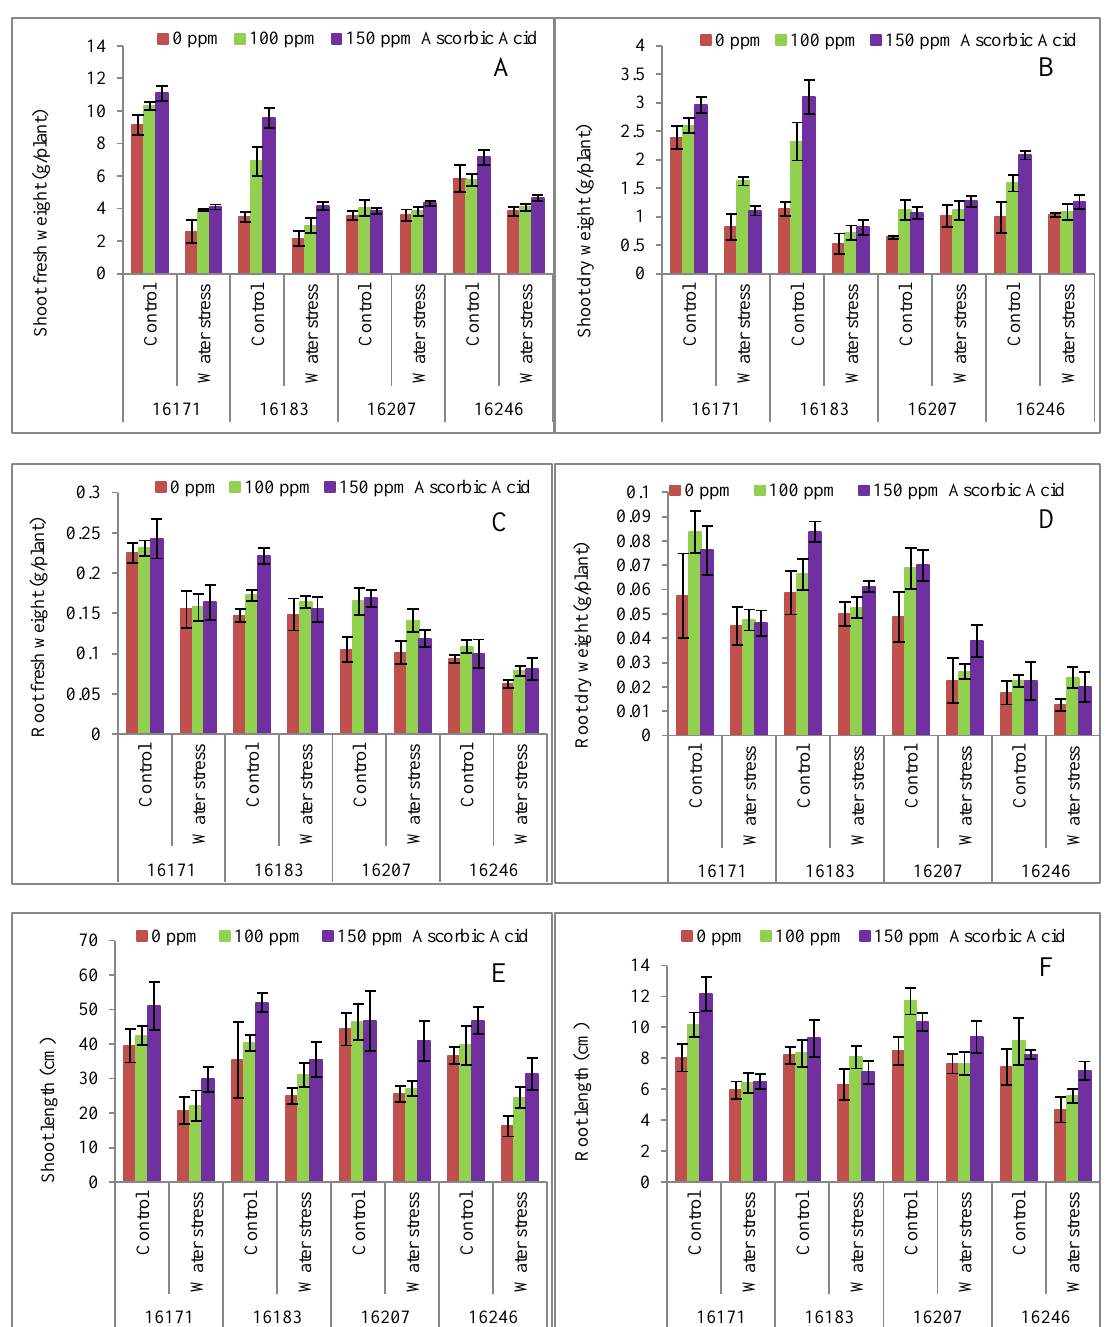
Figure 1. Shoot fresh ( A ) and dry ( B ) weights, root fresh ( C ) and dry ( D ) weights, shoot ( E ) and root ( F ) lengths, of four cultivars of safflower ( Carthamus tinctorius L.) foliarly treated with ascorbic acid subjected to water stress conditions (mean ± S.E.).